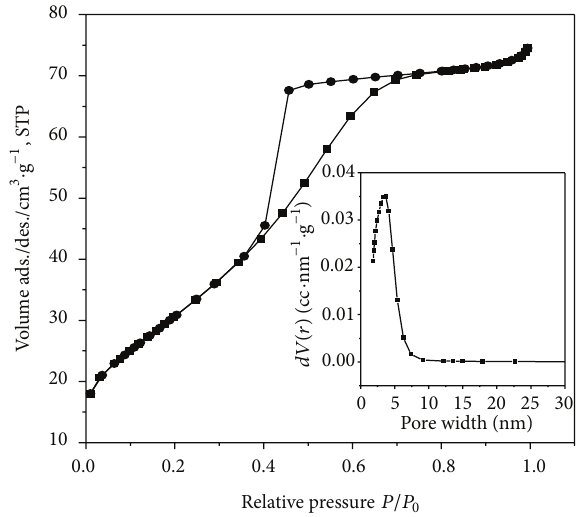
Figure3:Nitrogenadsorption-desorptionisothermofMTiO 2 /RRP. BJH pore size distributions are shown in the